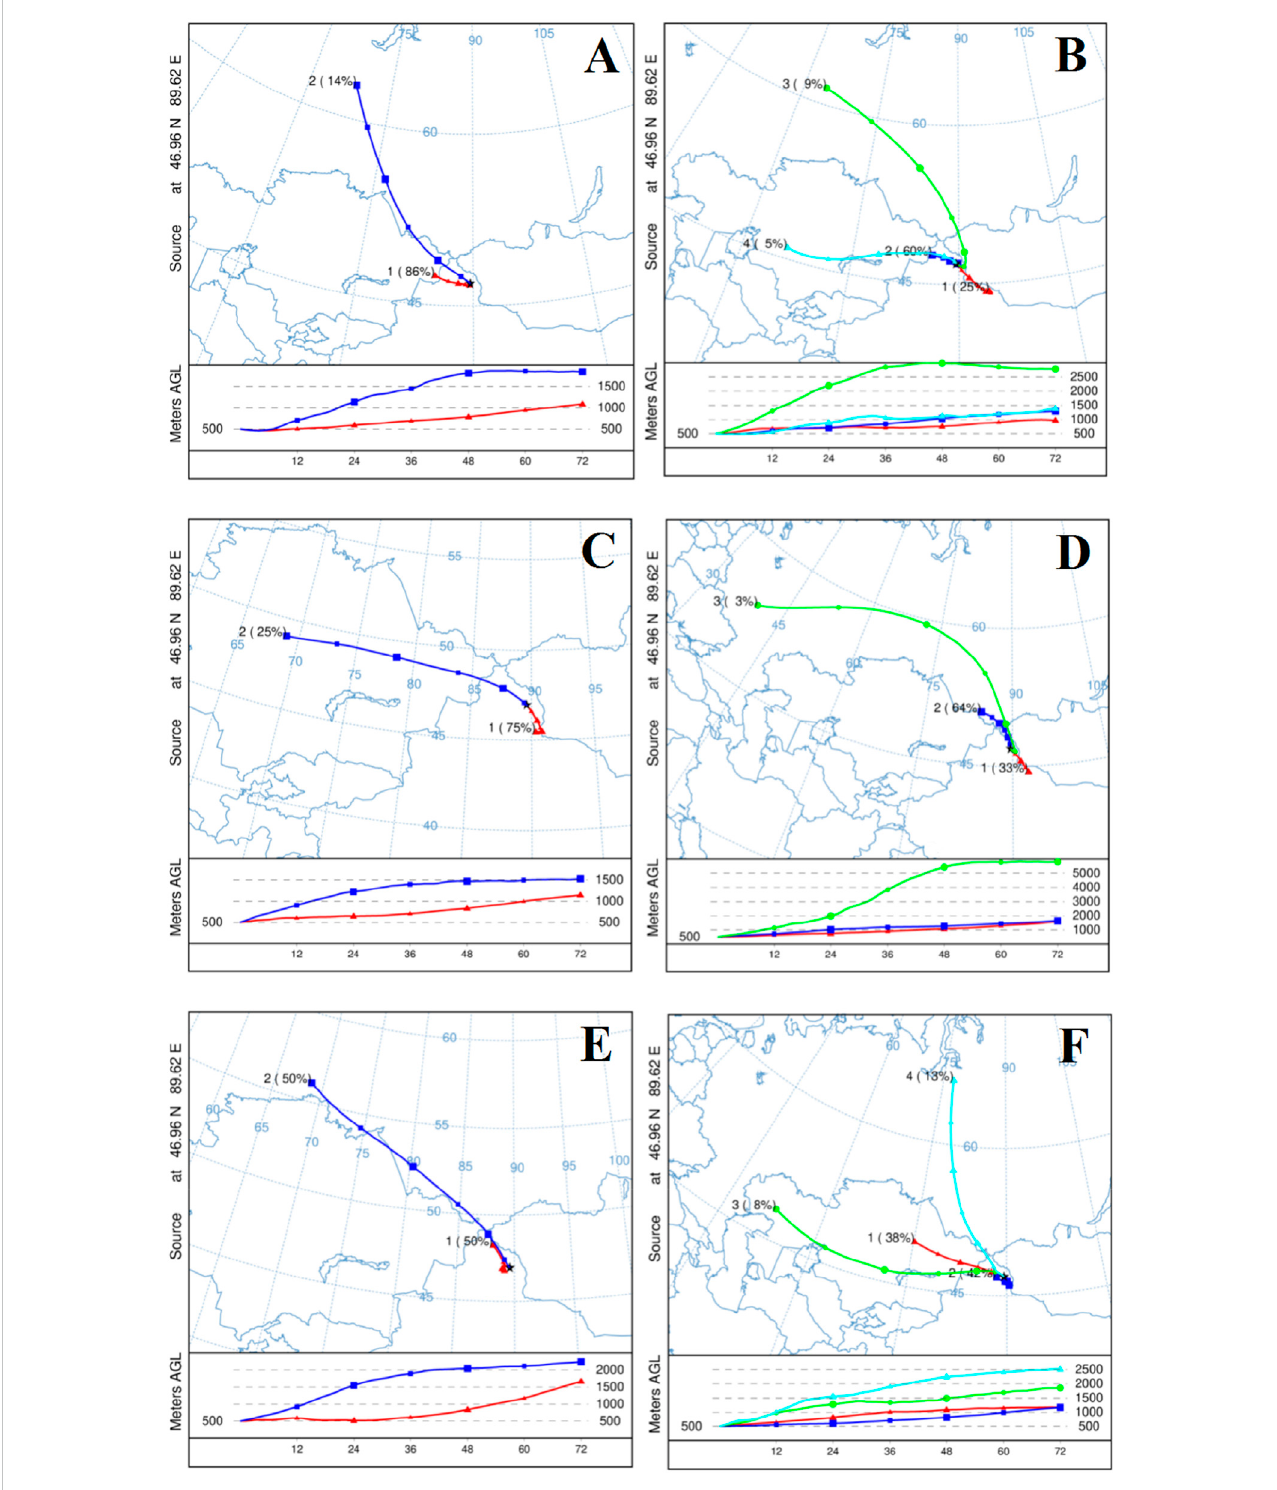
FIGURE 14 Clustering analysis of 72 h backward trajectory of Altay sampling site, where (A) is from November to December 2018; (B – D) are January-February, March and November-December 2019, respectively; (E) (F) are January-February and April 2020, respectively.